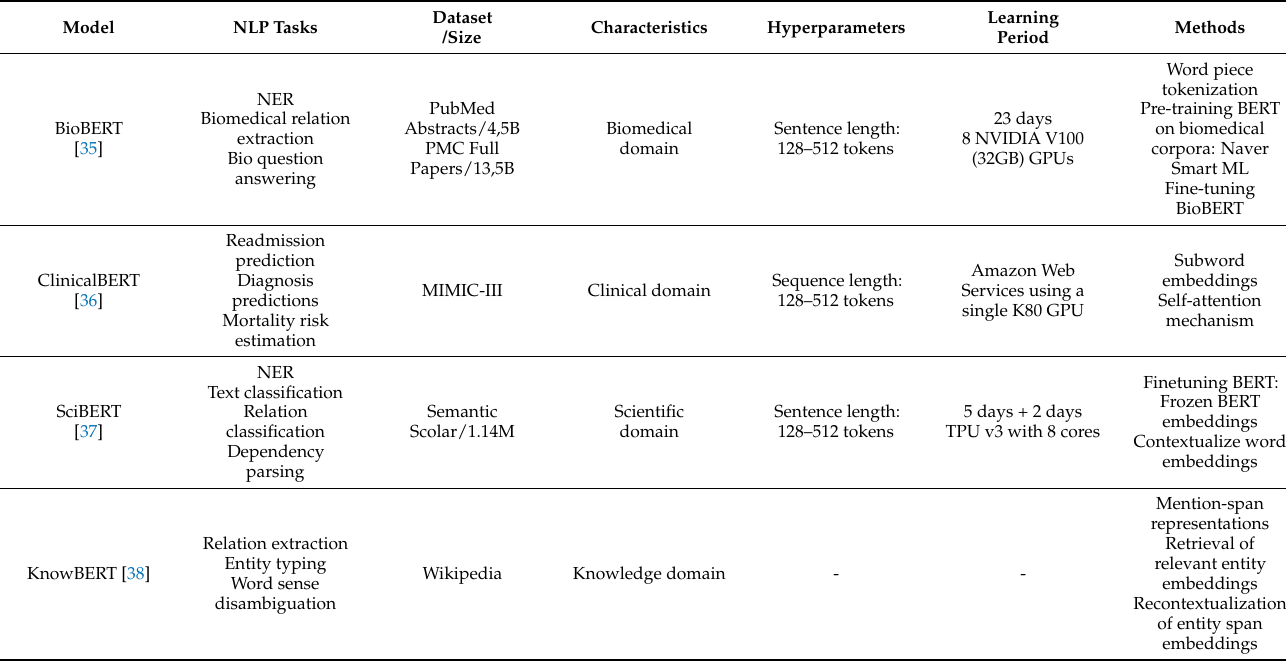
Table 3. Comparative study of BERT